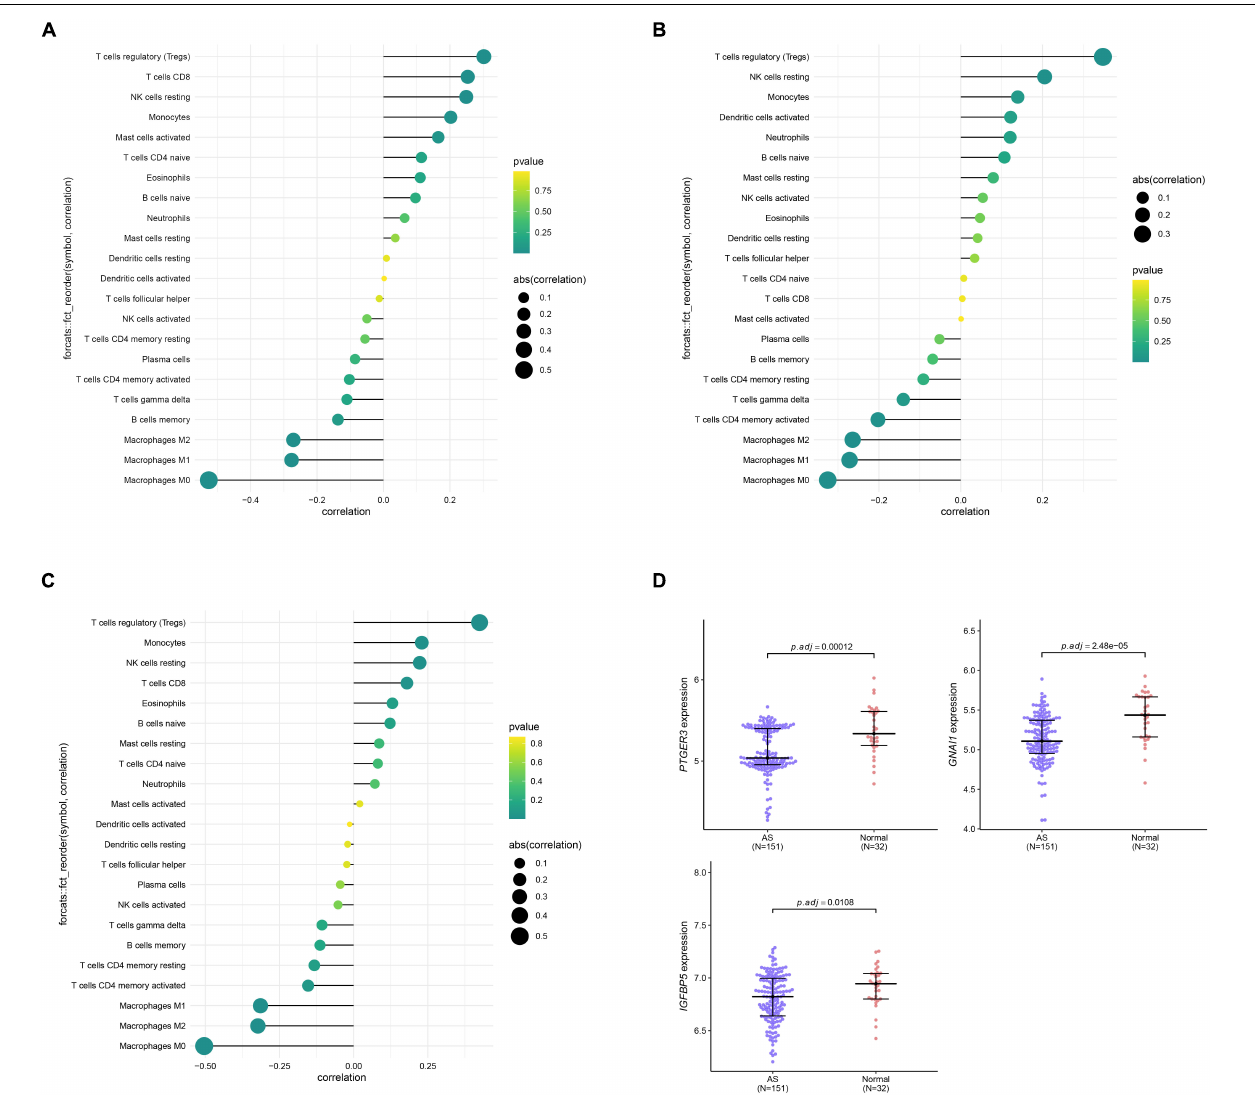
FIGURE 11 | Correlation analysis between the three genes PTGER3 (A) , GNAI1 (B) , IGFBP5 (C) , and 22 immune cells infiltration level. (D) The expression level of three genes between normal and AS tissue.